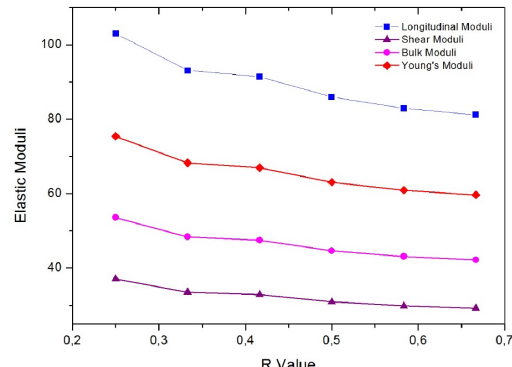
Figure 2. Variation of elastic modules for the BPS glass system. Source: the autors (2018).